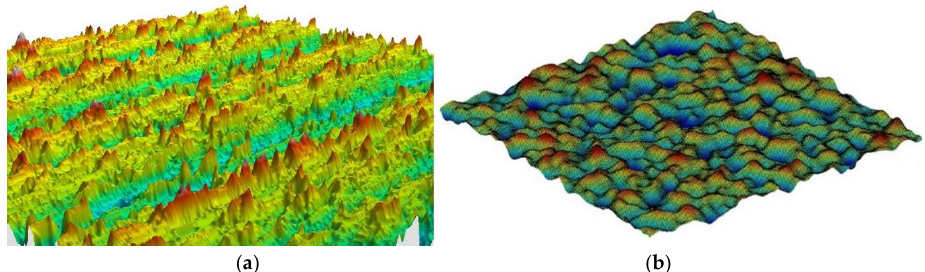
Figure 4. (a) Surface profile of metal, which is scanned by white light interferometer; ( b ) examples of rough surfaces generated by computers.